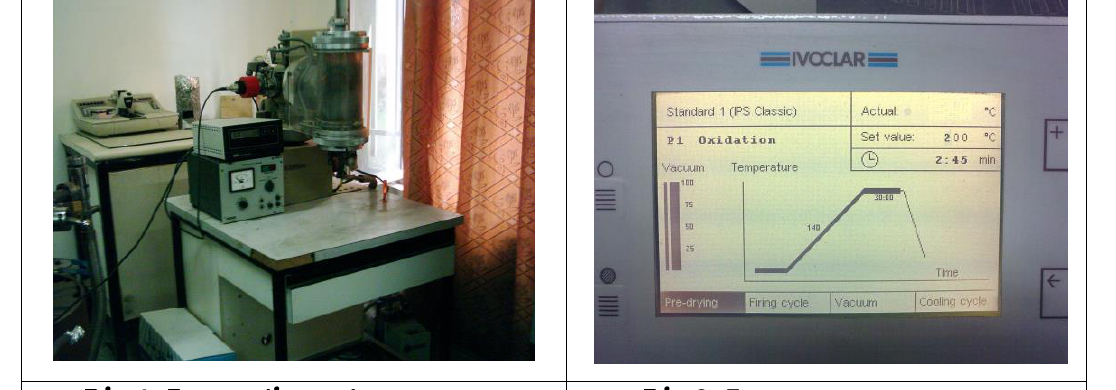
Fig. 1: Evaporation system. Fig. 2: Furnace